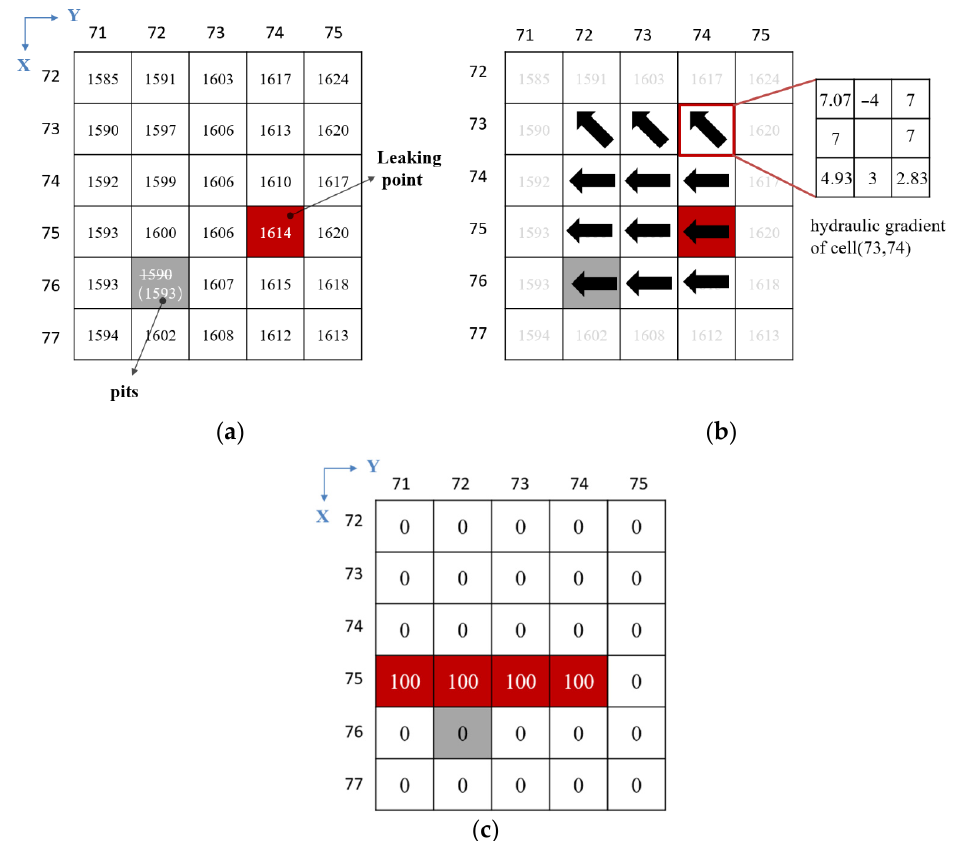
Figure 10. Matrix calculus process, the cell in red color means the cell is a part of leak spread area, the cell in grey means the cell is a pit, and the cell in white means it’s a normal cell: ( a ) Filling pits; ( b ) Flow direction; ( c ) Flow accumulation.